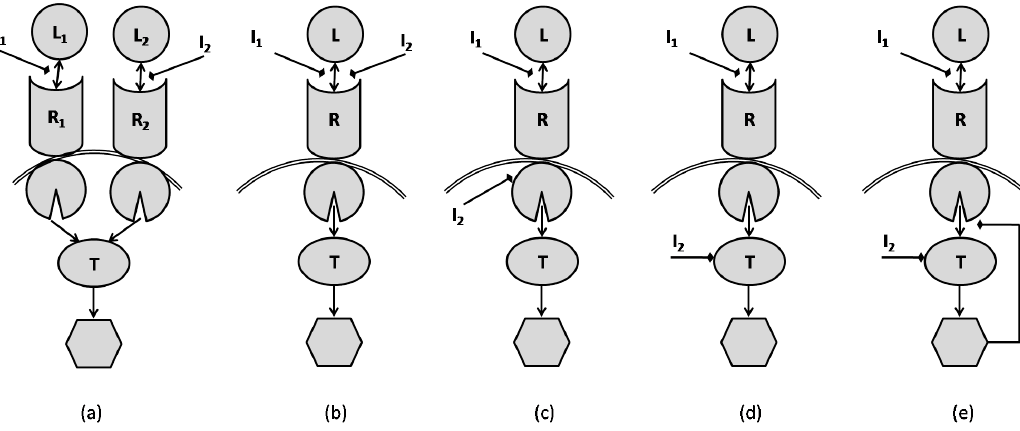
Figure 8. Drug combinations in signaling networks according to [38]: ( a ) Inhibition at two parallel pathways converging to a single target protein; ( b ) Inhibition at the same site of action; ( c ) Inhibition at different sites of action; ( d ) Inhibition at different levels; ( e ) Inhibition at different levels with a negative feedback